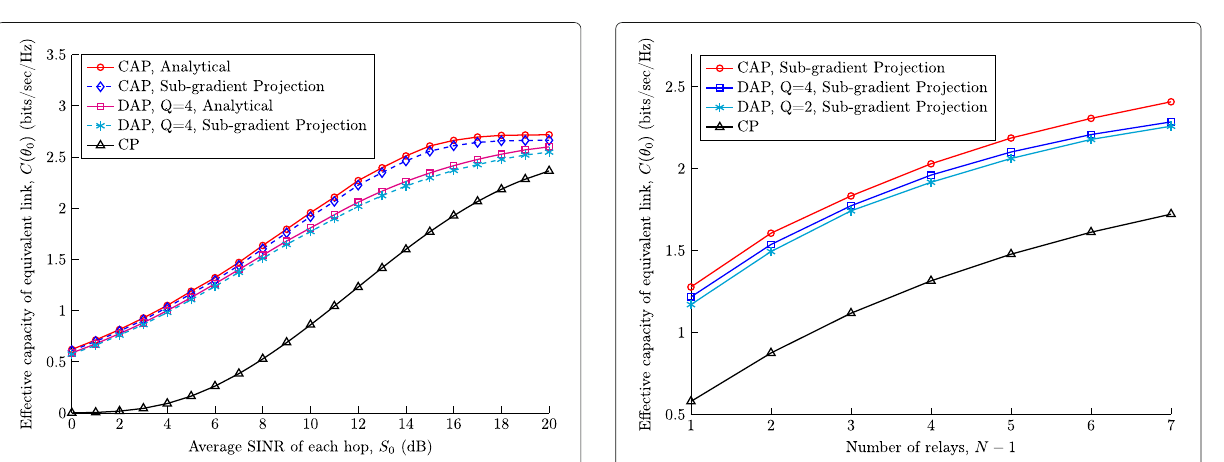
Fig. 2 Effective capacity versus average SINR of each hop in different power adaptation schemes, when parameters are obtained analytically or by sub-gradient projection, Rayleigh fading channels S 0 = E { s i } , ¯ P i = 1 W/Hz, 0 ≤ i ≤ 2, B 0 = 10 − 5 , θ 0 = 0.05